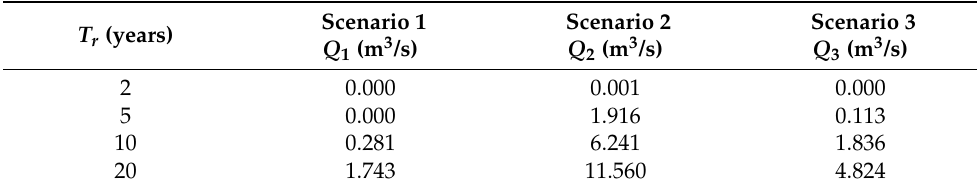
Table 5. Peak discharges ( Q ) determined by the Rational method for the analyzed scenarios and different return periods ( T r